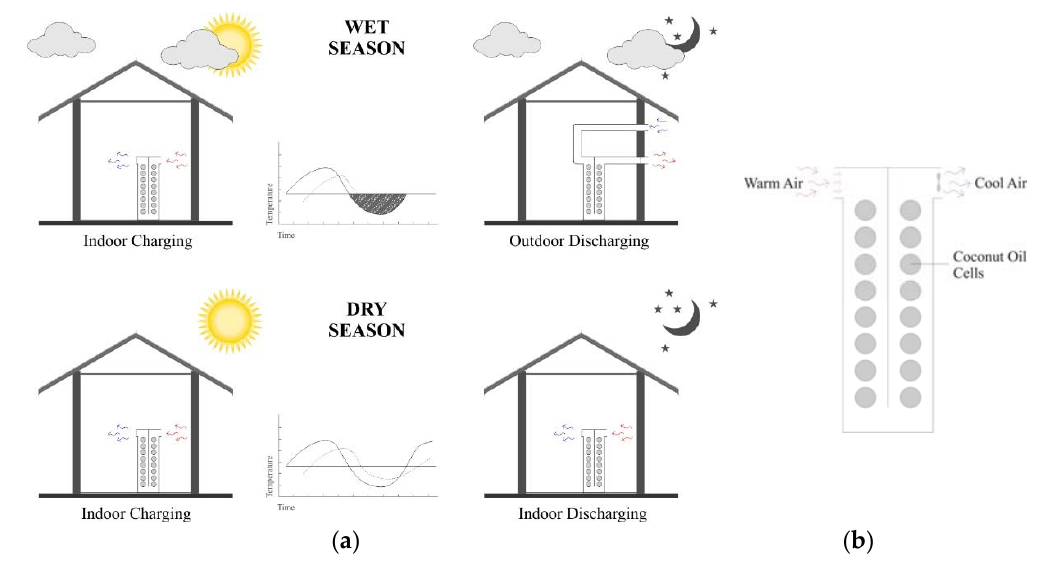
Figure 11. ( a ) Conceptual design of co_oil as TES in a house and ( b ) illustration of heat exchange between co_oil and its air environment.